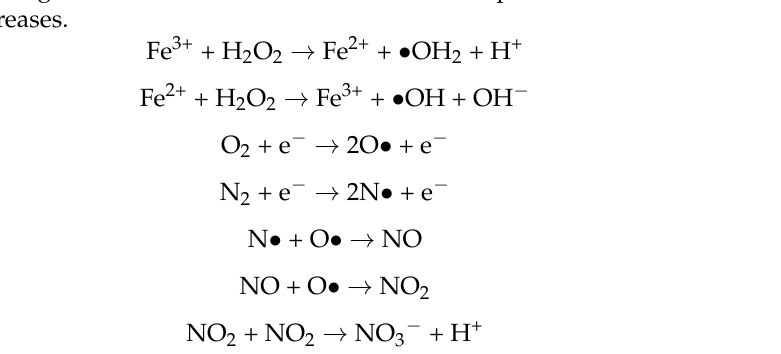
Figure 7. Effect of initial CV solution concentration on the degradation of CV. (Discharge voltage = 22 kV, frequency = 50 Hz, aeration O 2 = 3.0 L/min, red mud dosage = 2.0 g, conductivity = 26 μ s/cm).